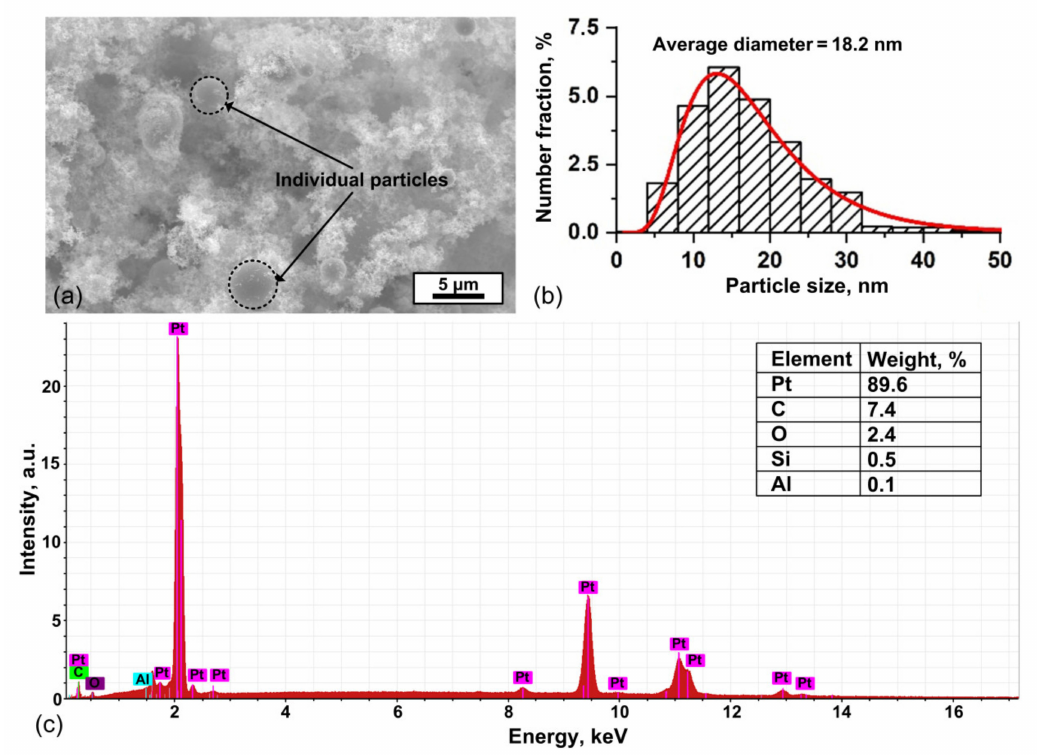
Figure 2. ( a ) SEM image, ( b ) histogram of the particle size distribution, and ( c ) typical EDX spectrum of